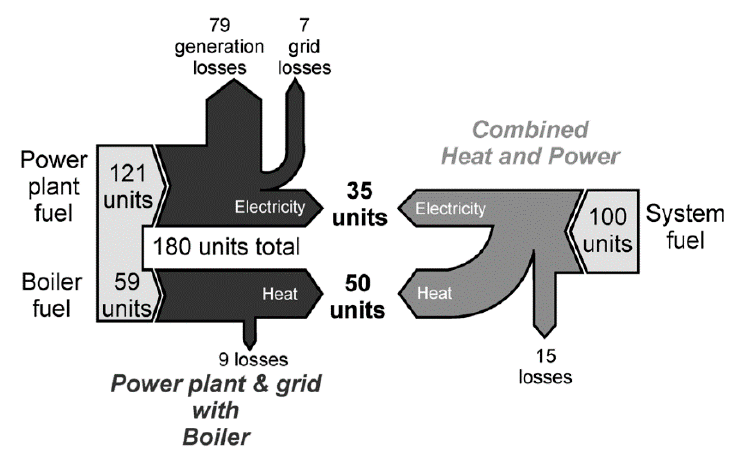
Figure 3. Sankey diagrams capturing the merits associated with producing heat. The performances captured here are descriptive subject to the system, as well as the country [94].